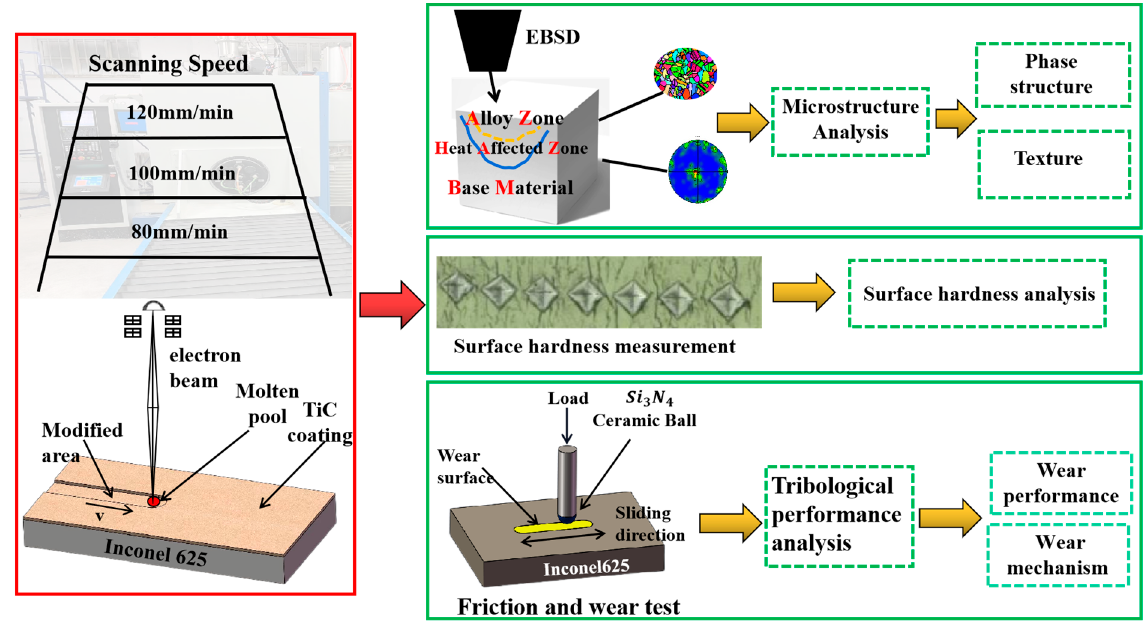
Figure 1. Experimental Flow Chart.